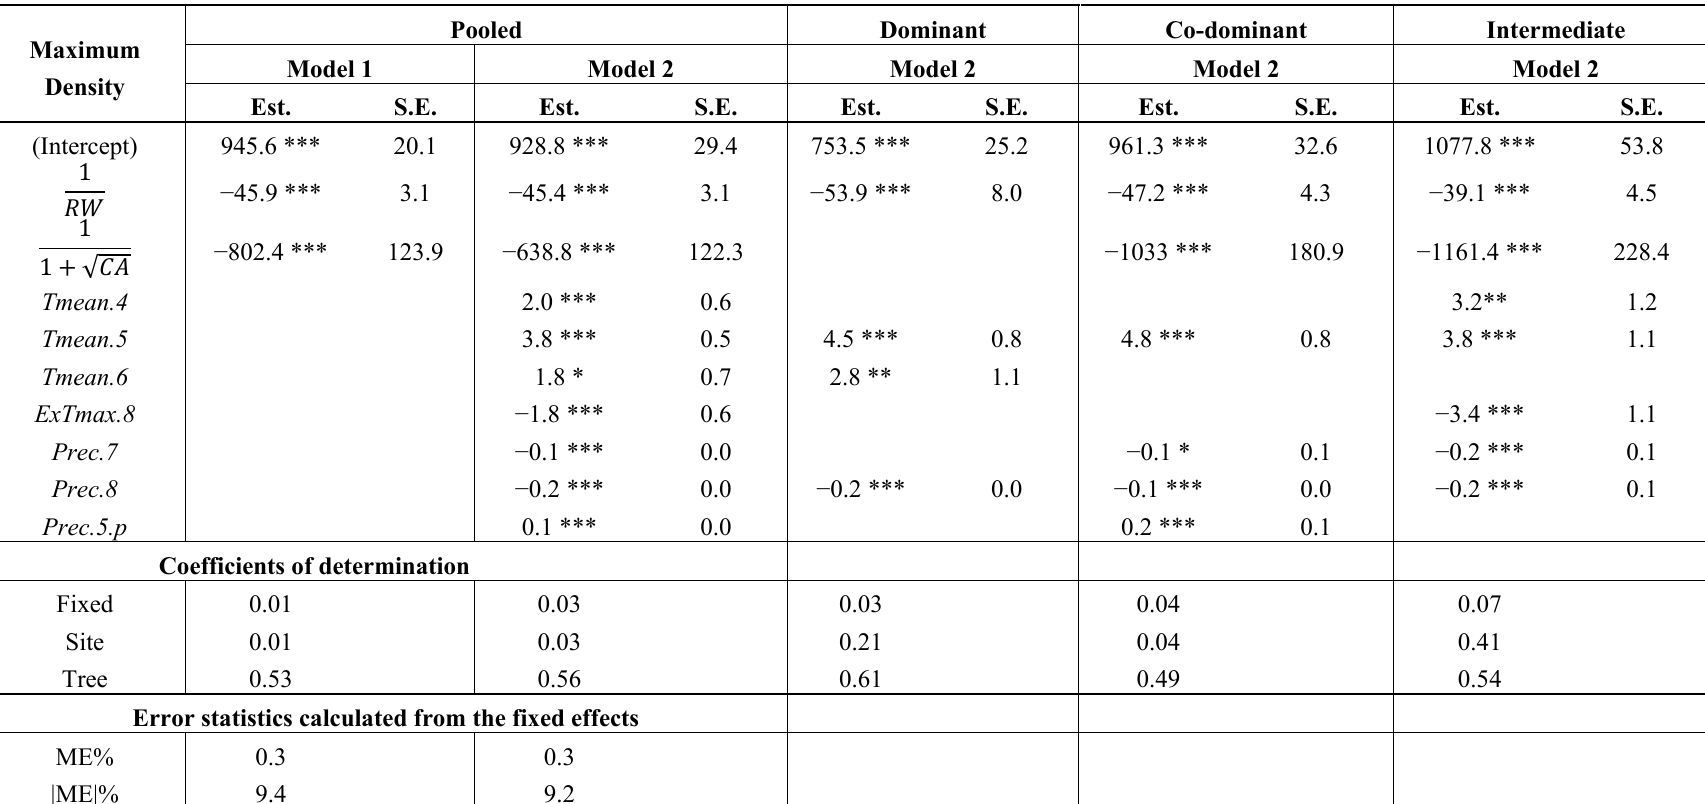
Table 4. Estimated coefficients (Est.) and associated standard error (S.E.) for maximum ring density at different dominance